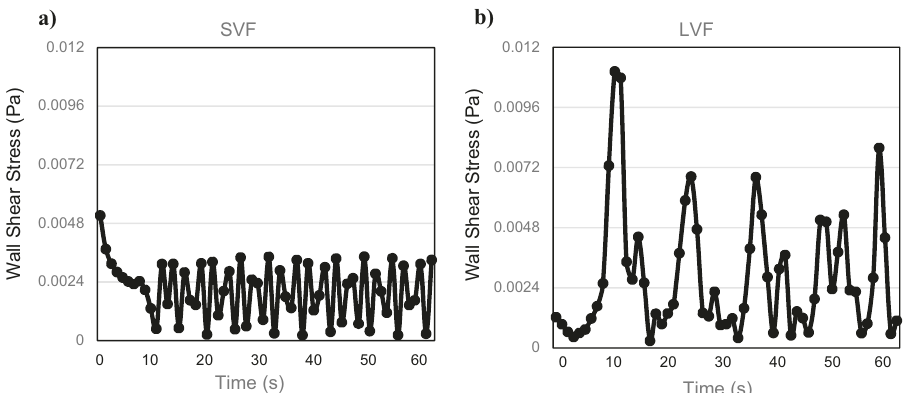
Fig. 3 The dynamics of wall shear stress. a SVF experiment. b LVF experiment. Wall shear stress (Pa) is calculated at a position 6 cm down the channel walls using the 2-D CFD model.